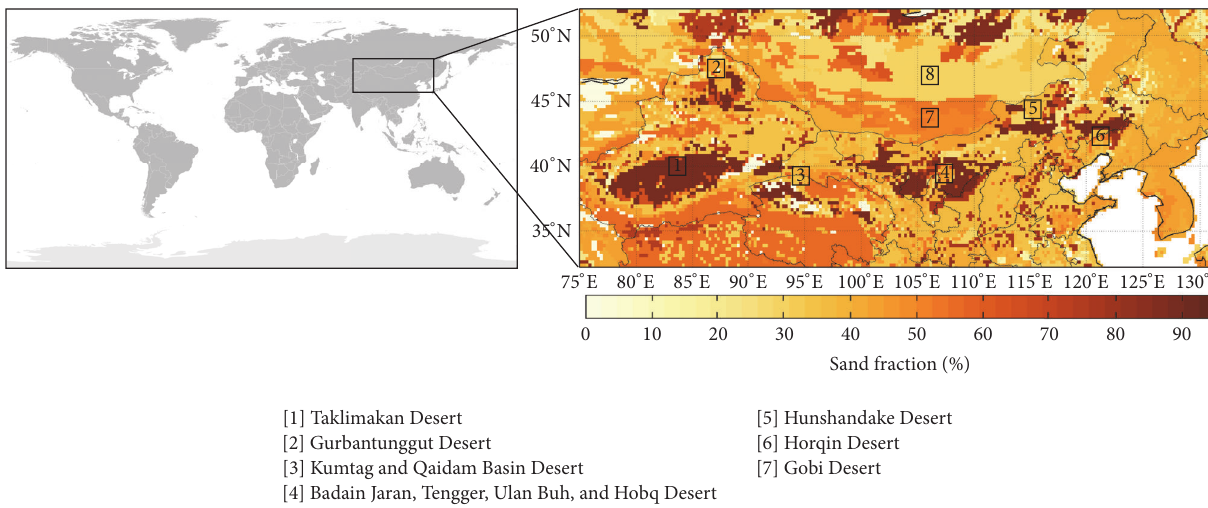
Figure 1: The East Asia sand fractions were retrieved according to the Harmonized World Soil Database (HWSD). All of the identified desert regions were recognized as the most famous dust sources around the world. Well-known desert regions (#1 to #6) are classified as sand by the USDA classification and exhibit a sand fraction that is greater than